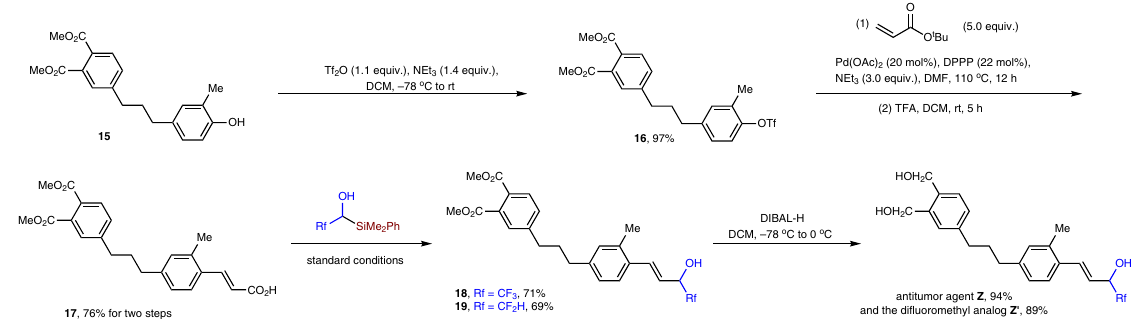
Fig. 8 Synthesis of antitumor agent Z and its di fl uoromethyl analog Z ′ . Tf 2 O tri fl uoromethanesulfonic anhydride, DPPP bis(diphenylphosphino)propane,